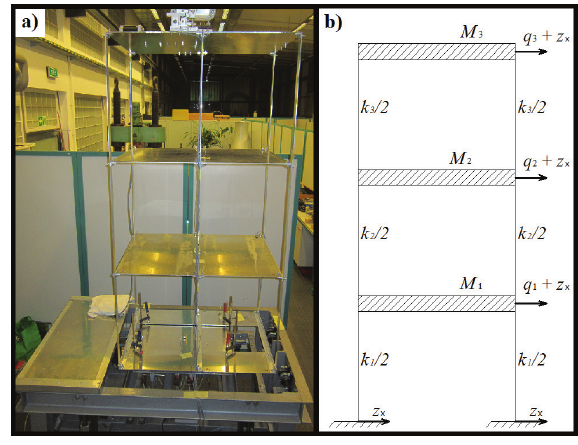
Figure 1: The slab-and-column model: (a) physical; (b)